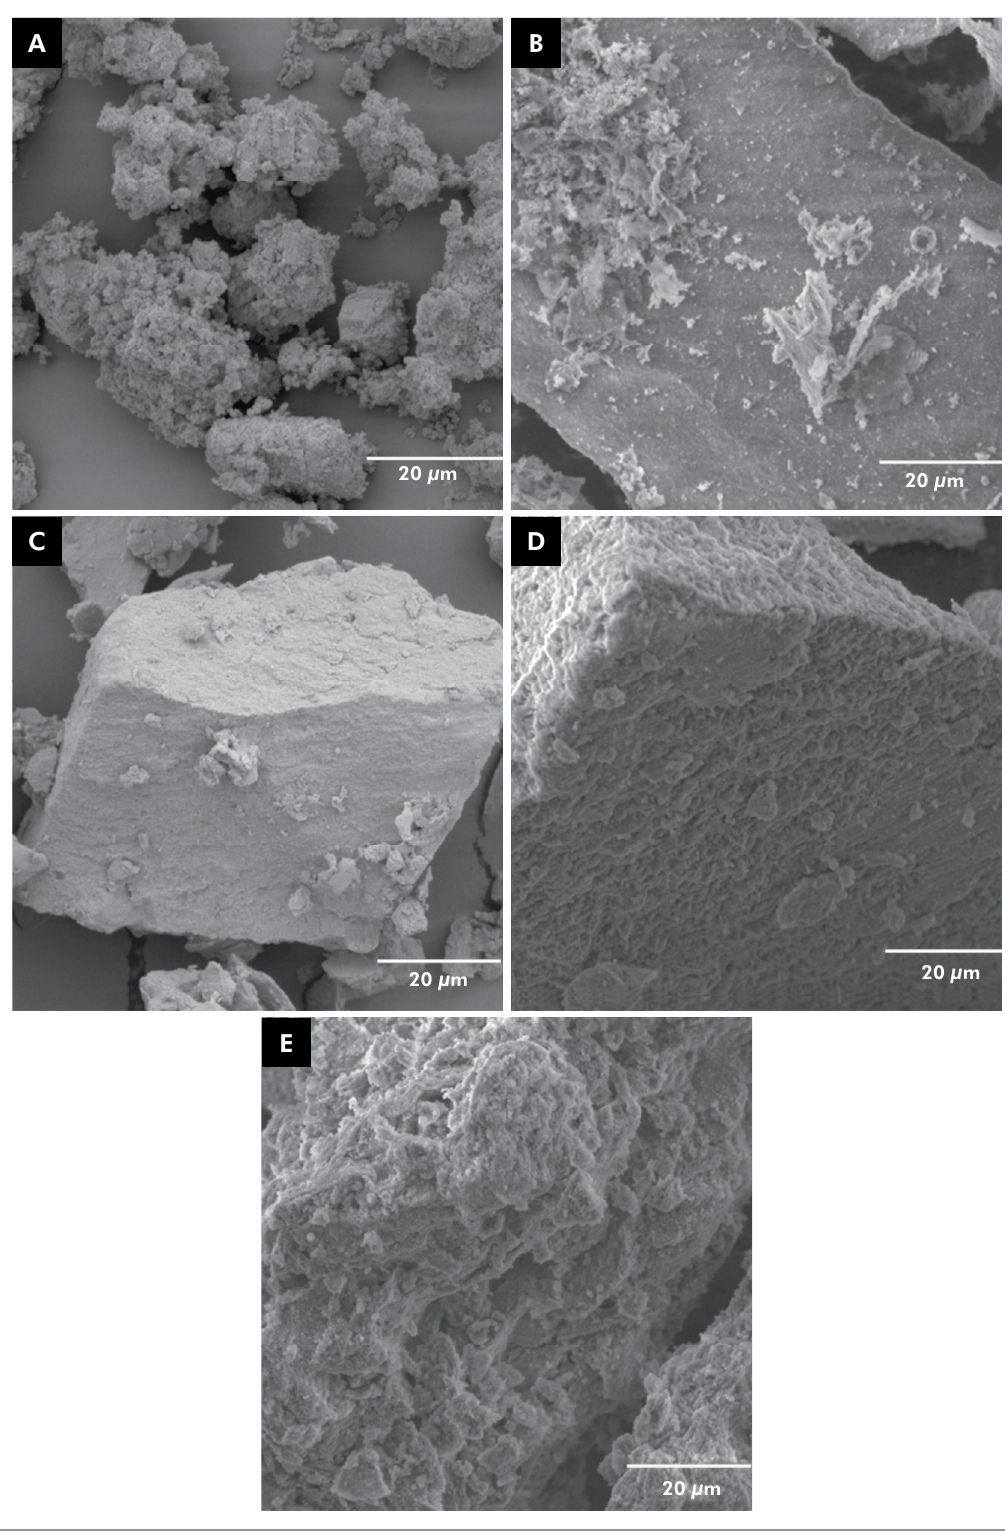
Figure 4. SEM photomicrograph illustrates the precursors C-LDH (A) and N-LDH (B). (C), (D), and (E), illustrate the SEM of F-LDH synthesized at 25ºC for 2 h. Fluoride product (F-LDH/1) synthesis from C-LDH precursor (C). Fluoride product (F-LDH/5) synthesis from N-LDH colloidal suspension (D). Fluorinated product (F-LDH/9) synthesis from N-LDH powder (E). Note, the particle SEM micrographs show irregular and rough surfaces.